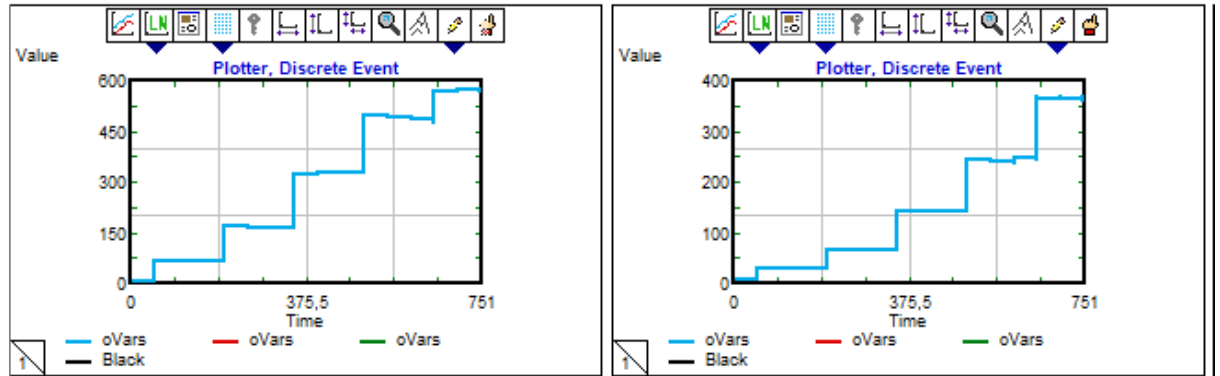
Figure 4: Graph after changes of maximum and minimum tension forces